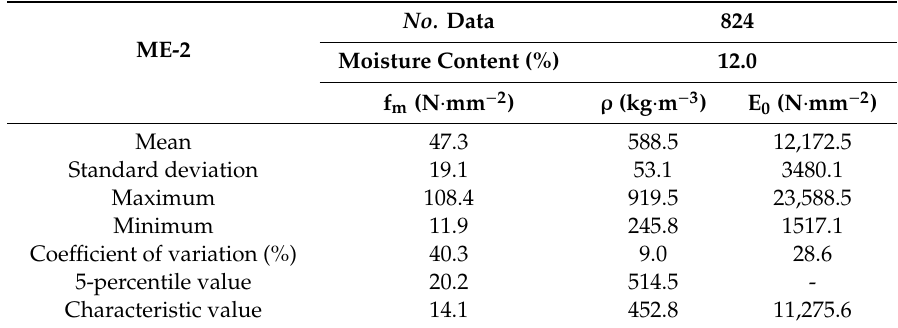
Table 4. Results of properties corresponding to grade ME-2. f m : bending strength; ρ : density; E 0 : modulus of elasticity in the bending parallel to grain.